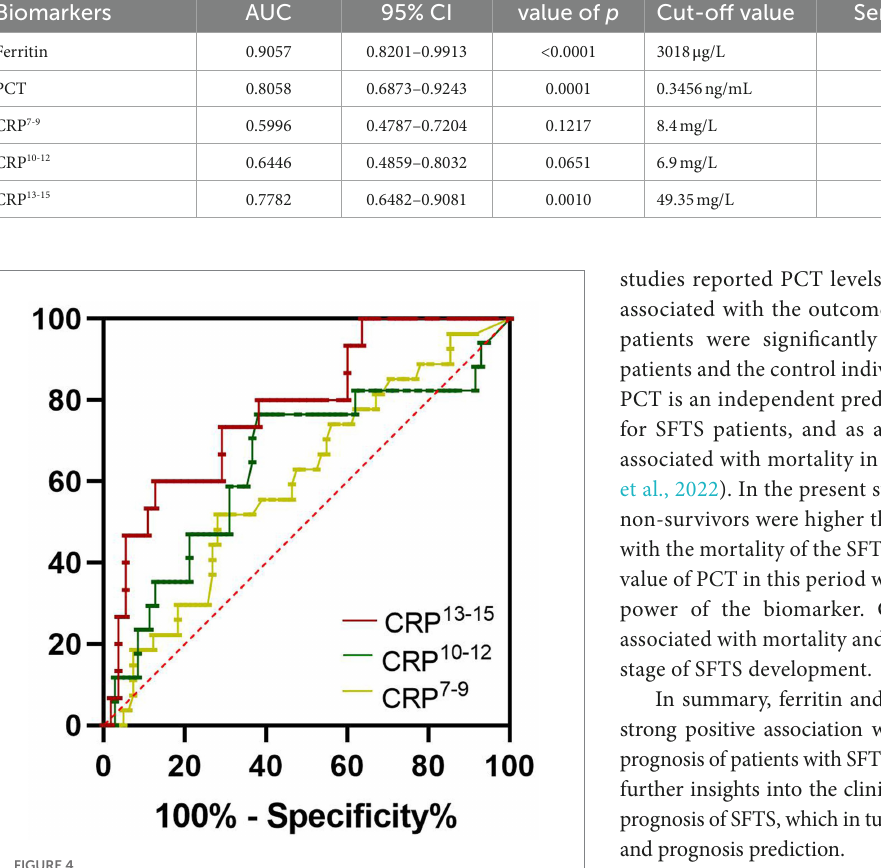
TABLE 2 Predictive values of inflammatory biomarkers for the mortality of SFTS. Biomarkers